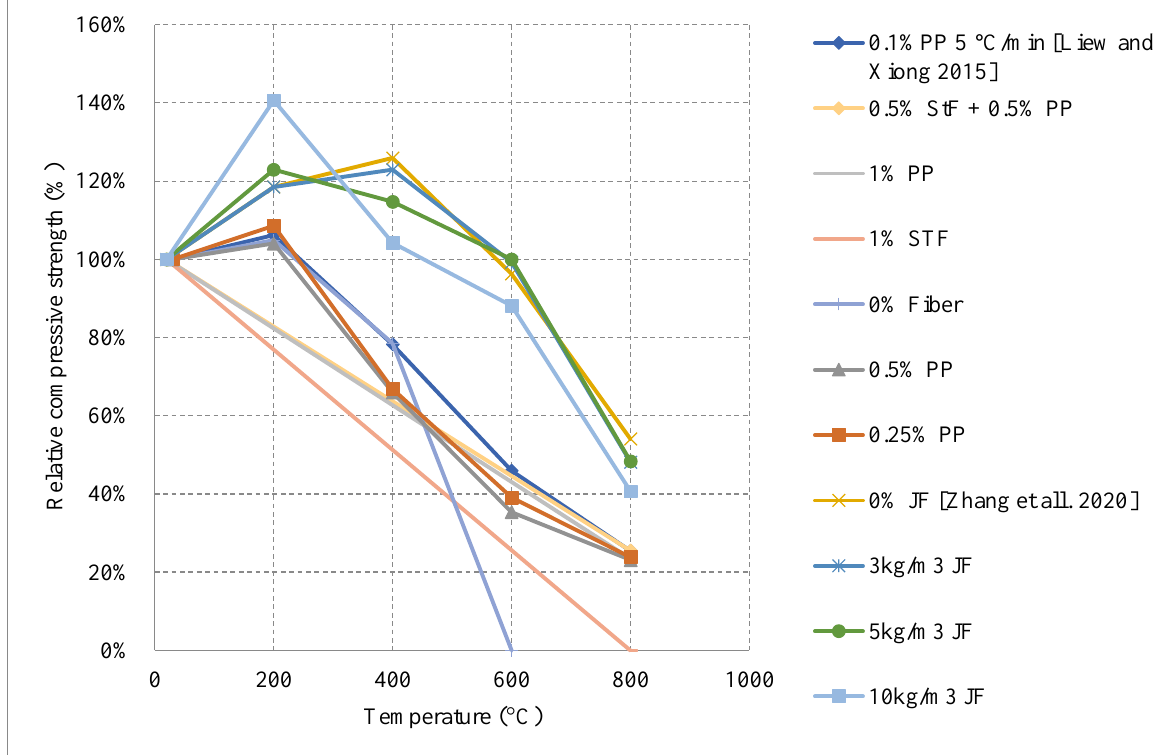
Figure 27. Relative compressive strength of furnace cooled UHPC with different constituents. JF: Jute Fibers, STF: Steel Fibers, PP: Polypropylene [47,94].